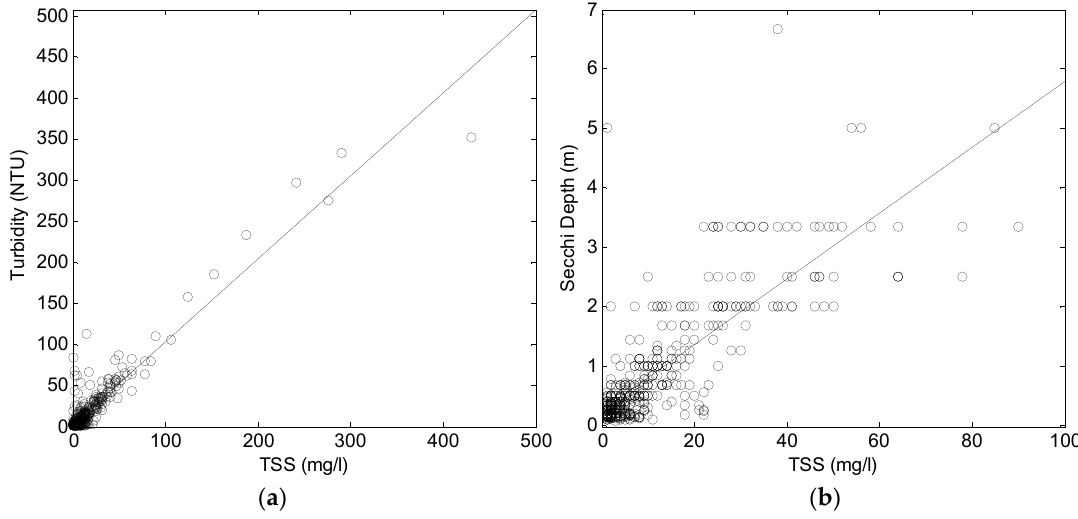
Figure 2. The relationship between ( a ) in situ measurements of total suspended solids (TSS) and turbidity ( r 2 = 0.89, n = 328, p < 0.001, y = x + 2.4) and ( b ) in situ measurements of TSS below 100 mg/L and secchi depth ( r 2 = 0.65, n = 469, p < 0.001, y = 0.055x + 24).